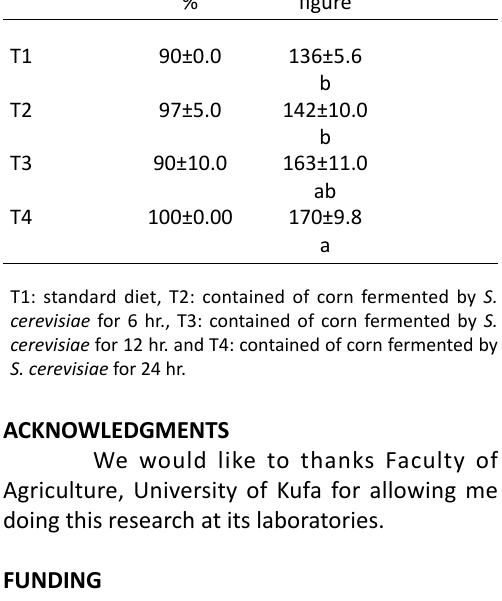
Table 6. Effect of fermented maize by S.cerevisiae in diets on viability and economic figure of broiler chicks for 5 th week